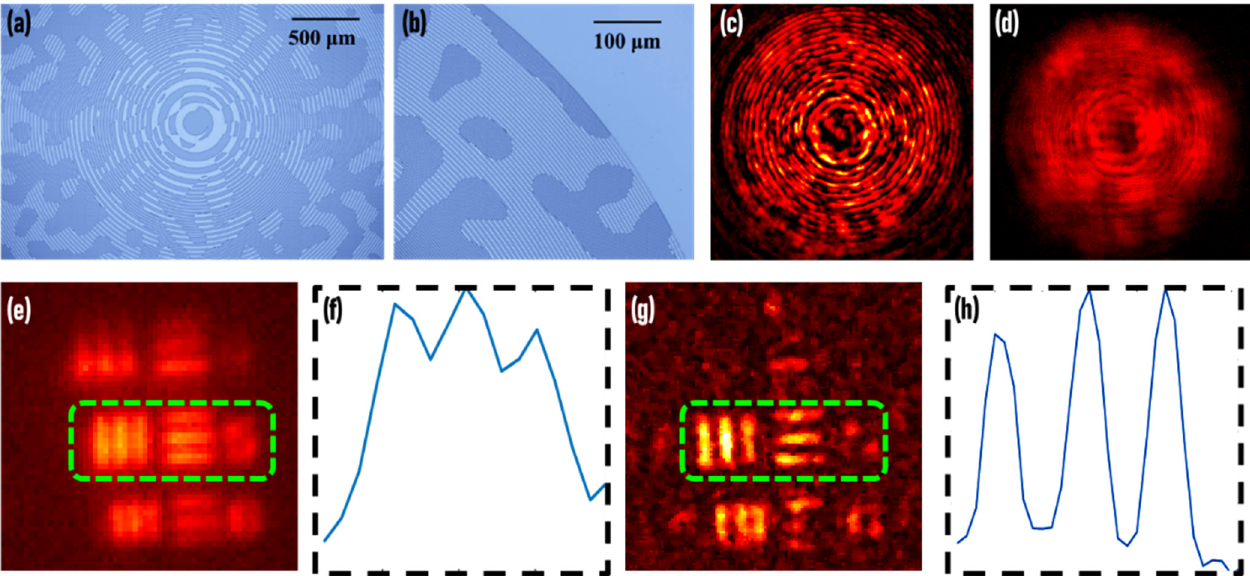
Figure 10. Optical microscope image of the ( a ) central part and ( b ) the outermost part of the fabricated diffractive lens. Images of the ( c ) PSH and ( d ) object hologram. ( e ) Direct imaging at one of the focal planes of the diffractive lens and ( f ) plot of averaged intensity values of the horizontal and vertical gratings shown in the green dotted box. ( g ) Reconstruction results and ( h ) plot of averaged intensity values of the horizontal and vertical gratings shown in the green dotted box. (Adapted from